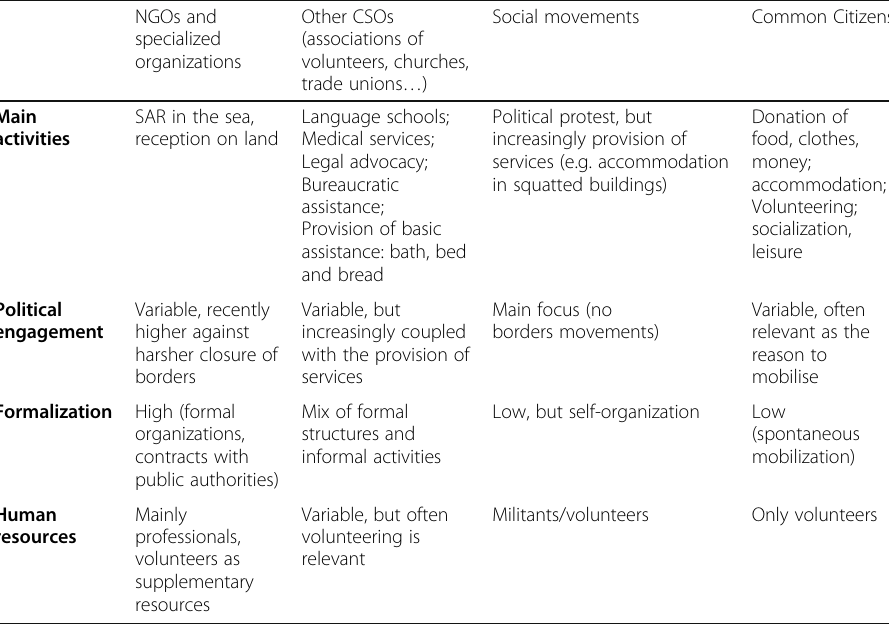
Table 2 Typology of supporters for asylum seekers and migrants with irregular